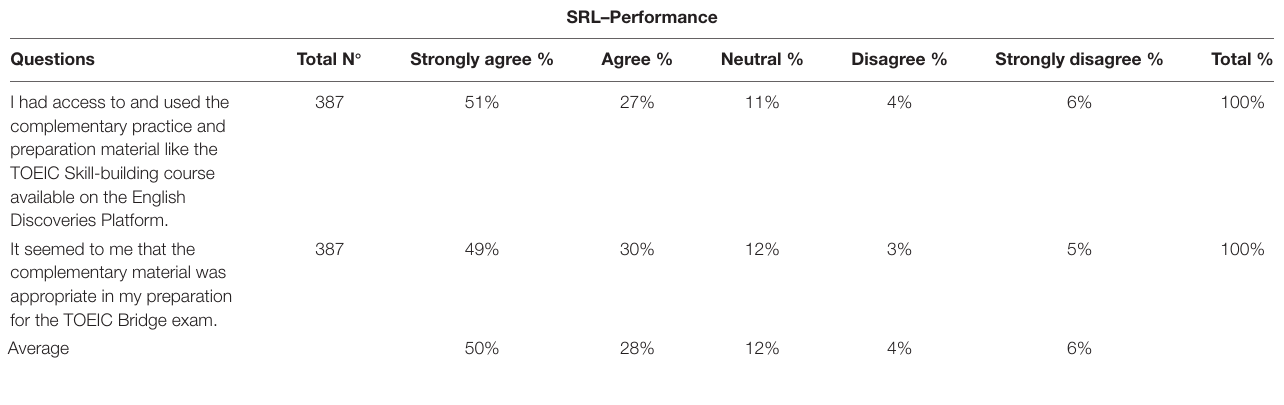
TABLE 5 | Survey results for self-regulated learning